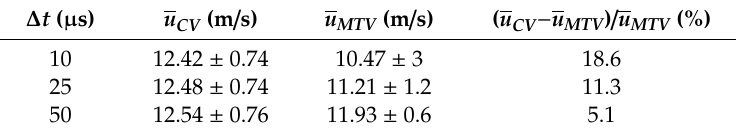
Table 6. Average velocities u CV and u MTV with estimated uncertainties, and relative deviation between u CV and u MTV calculated for the image data of Figure 13. The uncertainty range has a confidence level of 95%.